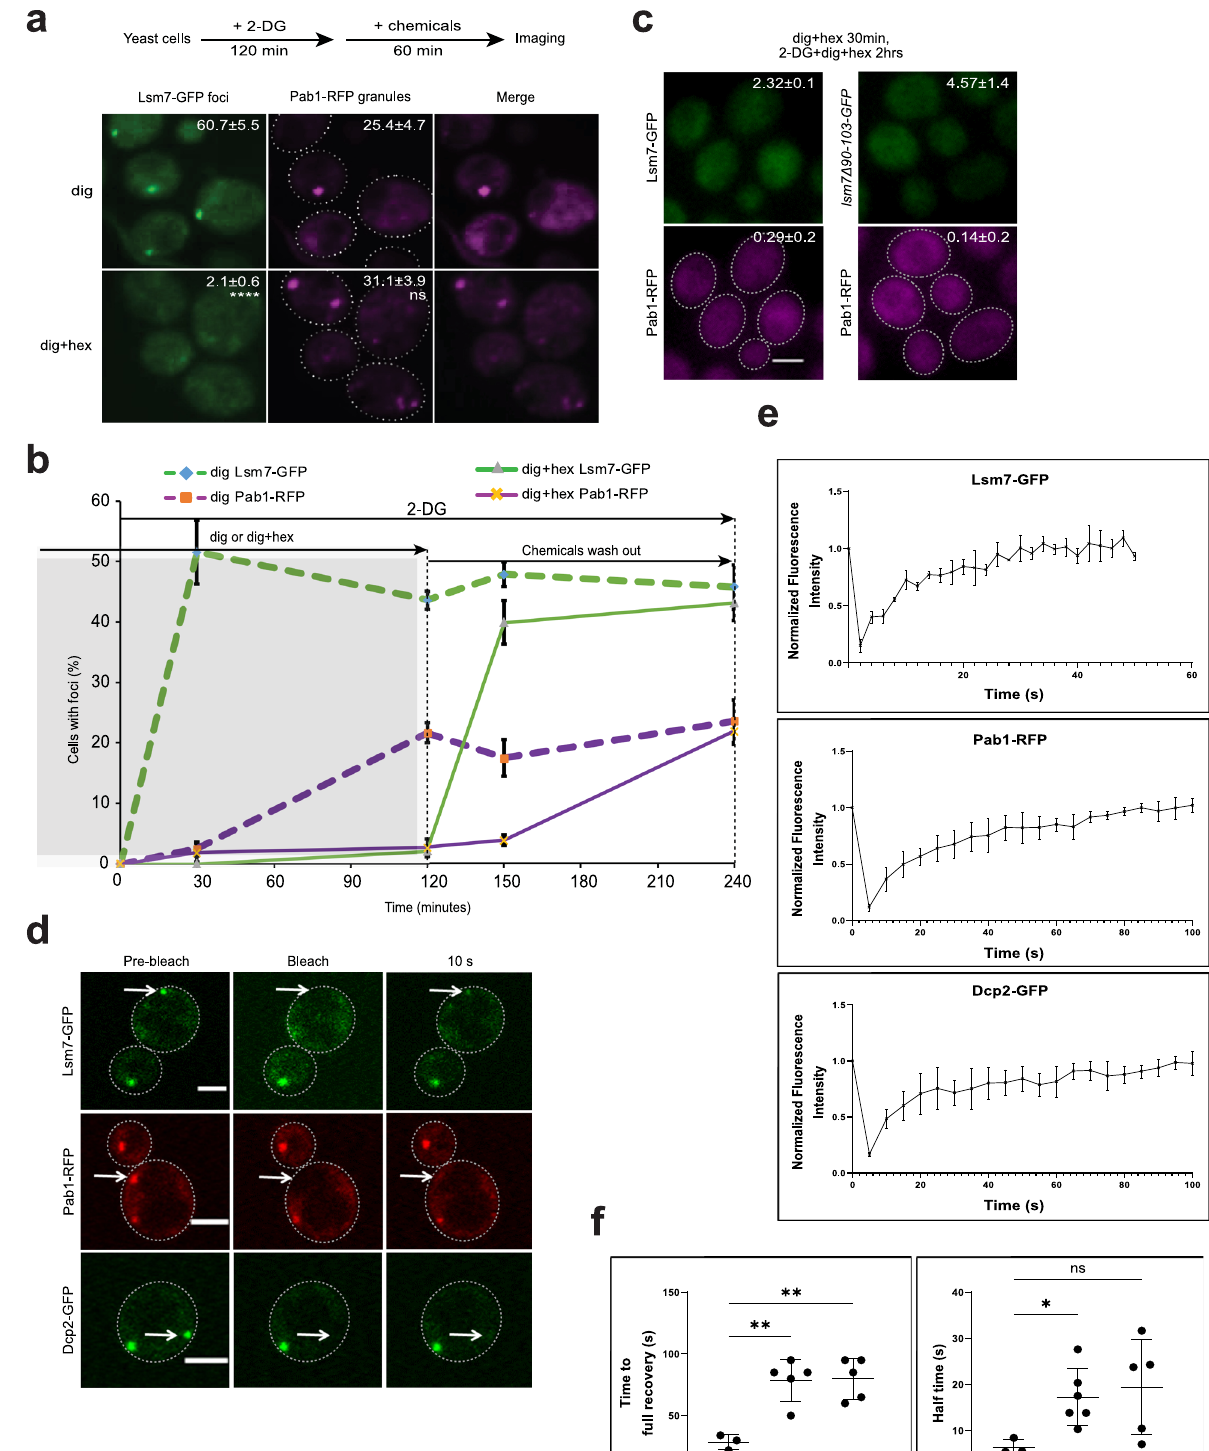
( lsm7 Δ 90-103) with 1,6-hexanediol, and noted that neither Lsm7 nor Pab1 granule formation was induced upon 2-DG treatment (Fig. 7b and c), indicating that Lsm7 foci formation might need to occur in order for Pab1 granule formation to initiate. Further- more, once 1,6-hexanediol was washed out from the media, Lsm7 condensates formed promptly while Pab1 granules formed afterward (Fig. 7b) as observed before (Fig.